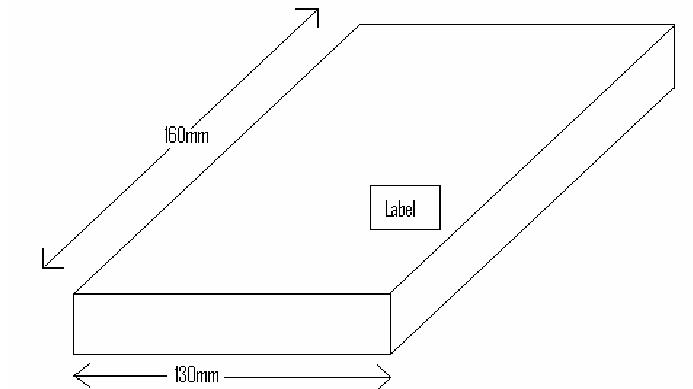
Figure 34. Experimental setup for estimation of fat content in pork belly cuts.